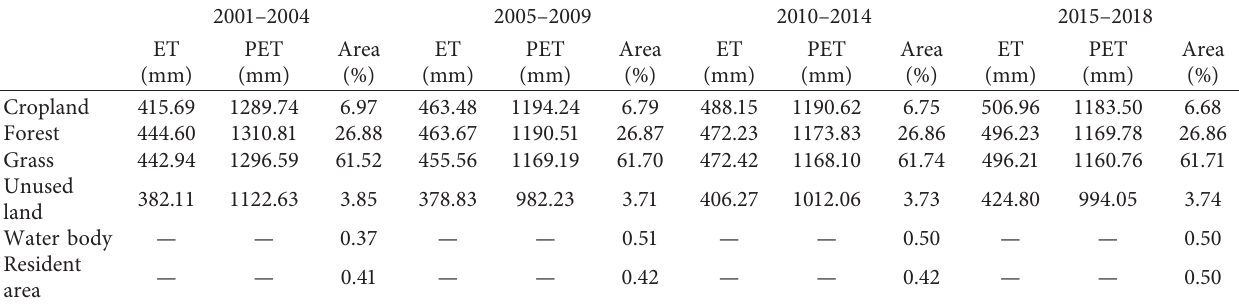
Table 2: Distributions of ET and PET in different types of land use from 2001 to